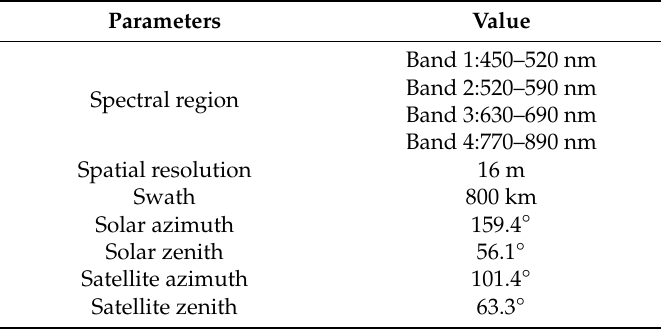
Figure 1. Position of Liaodong Shoal. Table 1. GF-1 wide-field view (WFV) image